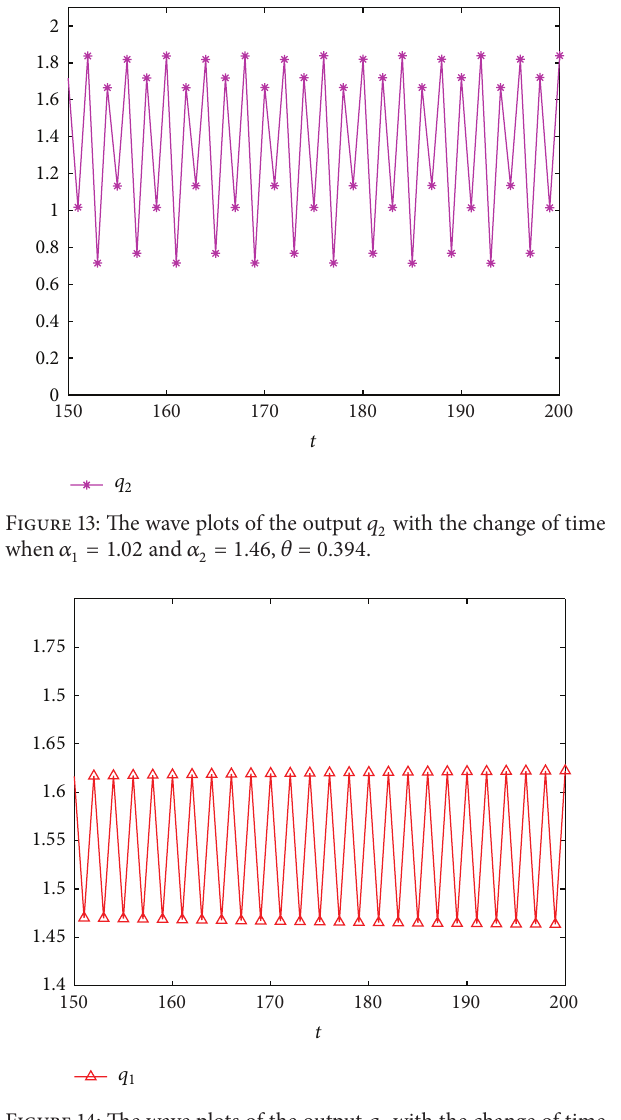
Figure 14: The wave plots of the output 𝑞 1 with the change of time when 𝛼 1 = 1.02 , 𝛼 2 = 1.46 and 𝜃 = 0.664 .